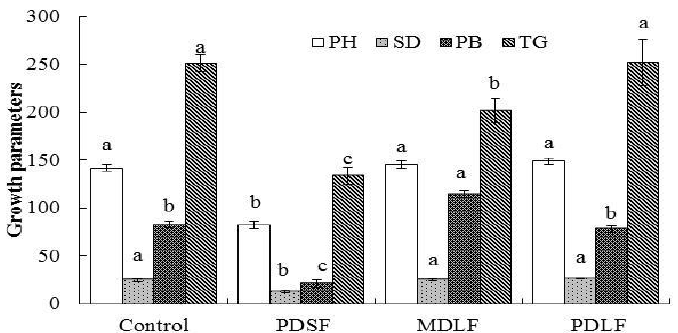
Figure 3. Effect of PDSF, MDLF, and PDLF fulvic acids (FA) on plant height (PH), stem diameter (SD), plant biomass (PB), and thousand-grain weight (TG) of the Maize crop; error bar shows the standard error of means ( n = 4). The least significant differences (LSD 0.05 ) are at 5% level of significance, different letter on top of each bar showing significant differences between treatments.